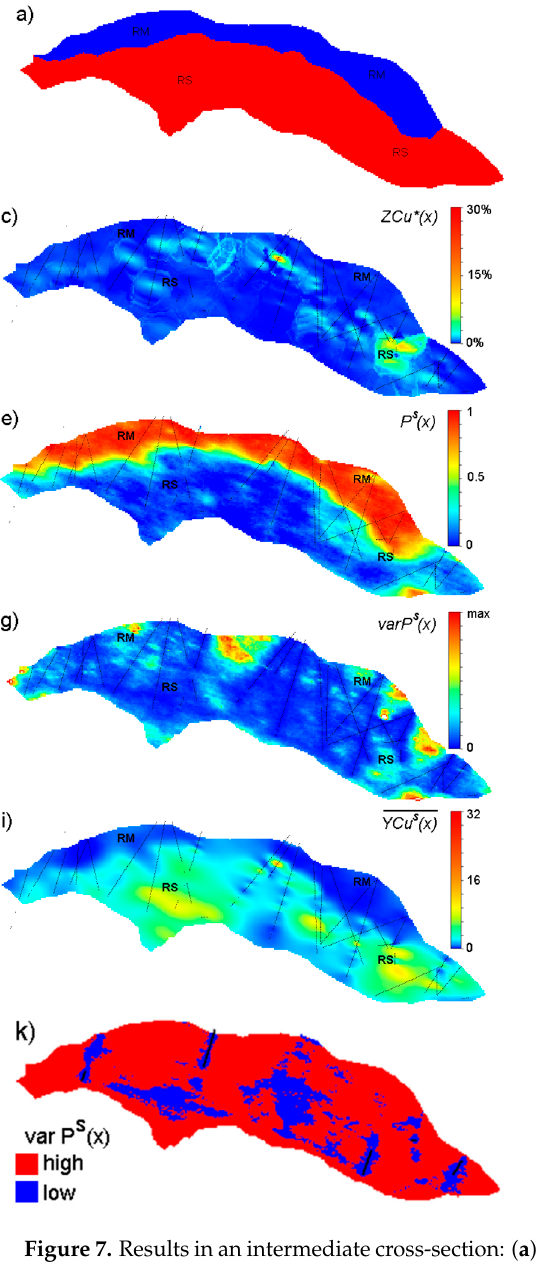
( f ) Figure 8. Experimental variograms of P ( x ) and Y Cu ( x ) variables for the three OX, OY, and OZ directions: OX similar to W-E 20° E (90°; − 20°), OY similar to N-S (0°; 0°) and OZ similar to W-E 70° W (90°; 70°). ( a ) SPH1 (C 1 = 0.106; a 1 = 300 m); ( b ) SPH 1 (C 1 = 0.106; a 1 = 200 m); ( c ) SPH 1 (C 1 = 0.106; a 1 = 60 m); ( d ) SPH 1 (C 1 = 14,986; a 1 = 55 m); ( e ) SPH 1 (C 1 = 14,986; a 1 = 30 m); ( f ) SPH 1 (C 1 = 14,986; a 1 = 35 m). It is important to note that the values obtained with (5) are similar to the estimated ones, and the range is similar. This evidence is a good indicator that the proposed methodology can be applied and does not bias the results. In addition, for validation of results, the average of grades obtained by using OK and DSS for the massive ore region, the stockwork ore region, and both regions combined is compared in Table 3. Deviations are very small, confirming that the use of relative grades Y Cu ( x ) and DSS with local histograms generates unbiased realizations.